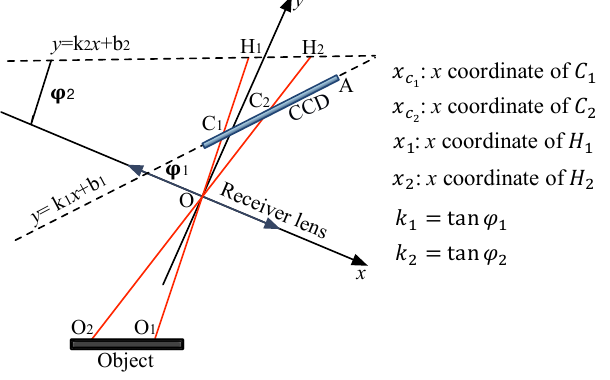
Figure 4. Working principle of the laser dithering compensation